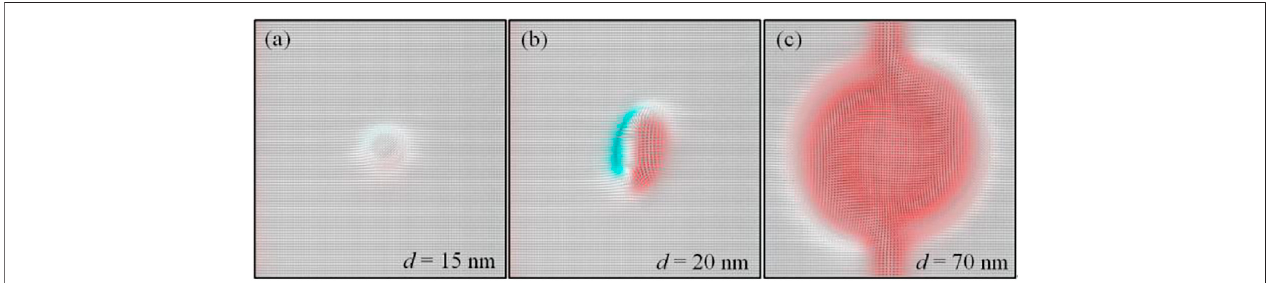
FIGURE6| (Coloronline) (A – C) The spin texture fordifferent diameter d , where M S = 5.8× 10 5 A/m, A = 1.5×10 − 11 J/m, K =8.0 ×10 5 J/m 3 , α =0.5. Thecurrent density is fi xed to 36 × 10 11 A/m 2 . DMI strength is 3.5 mJ/m 2